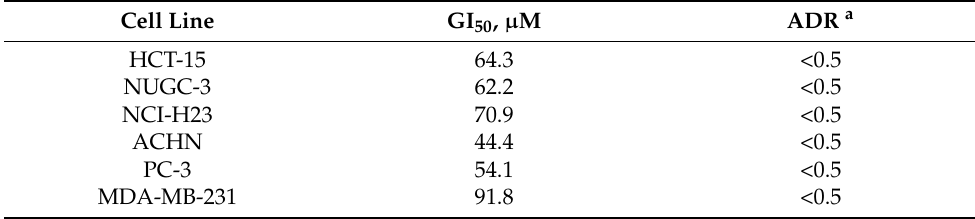
Table 2. Growth inhibition (GI 50 , µ M) values of 1 against human tumor cell